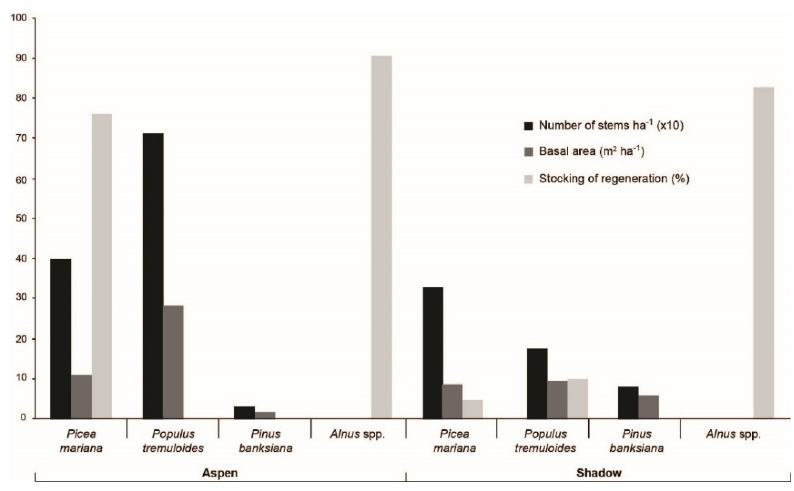
Figure 4. Characteristics of the contemporary forests surrounding Aspen and Shadow peatlands. Table 1. Pollen representation (selected species) of current vegetation of two stands in the study area. The first stand is located in the forest close to Aspen peatland. The second is located in landscape P3b (Figure 3).